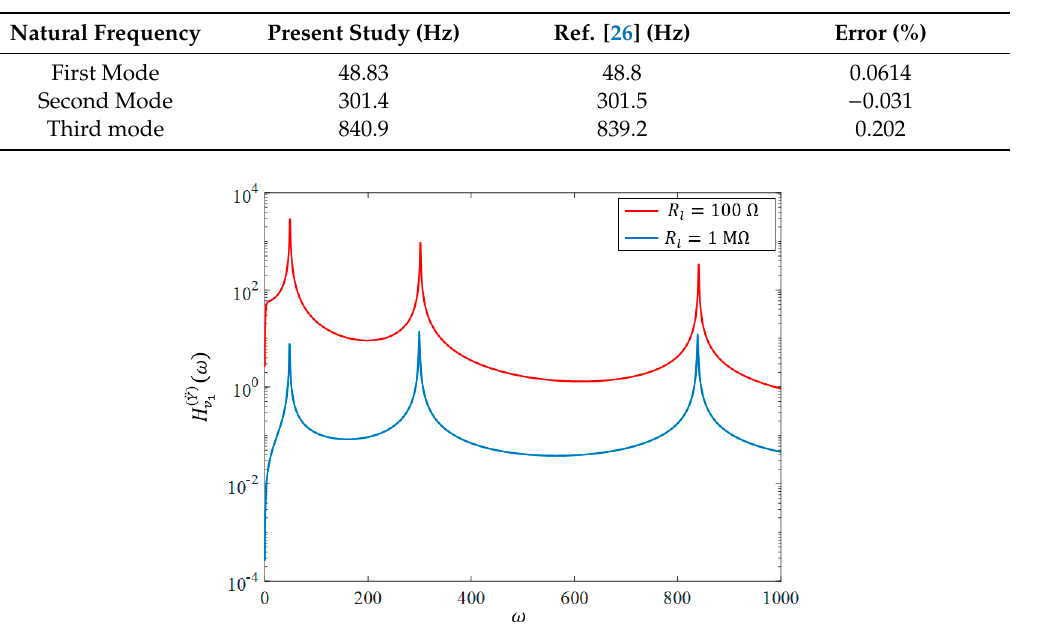
Table 7. Comparison between the natural frequencies when R l = 1 M Ω .